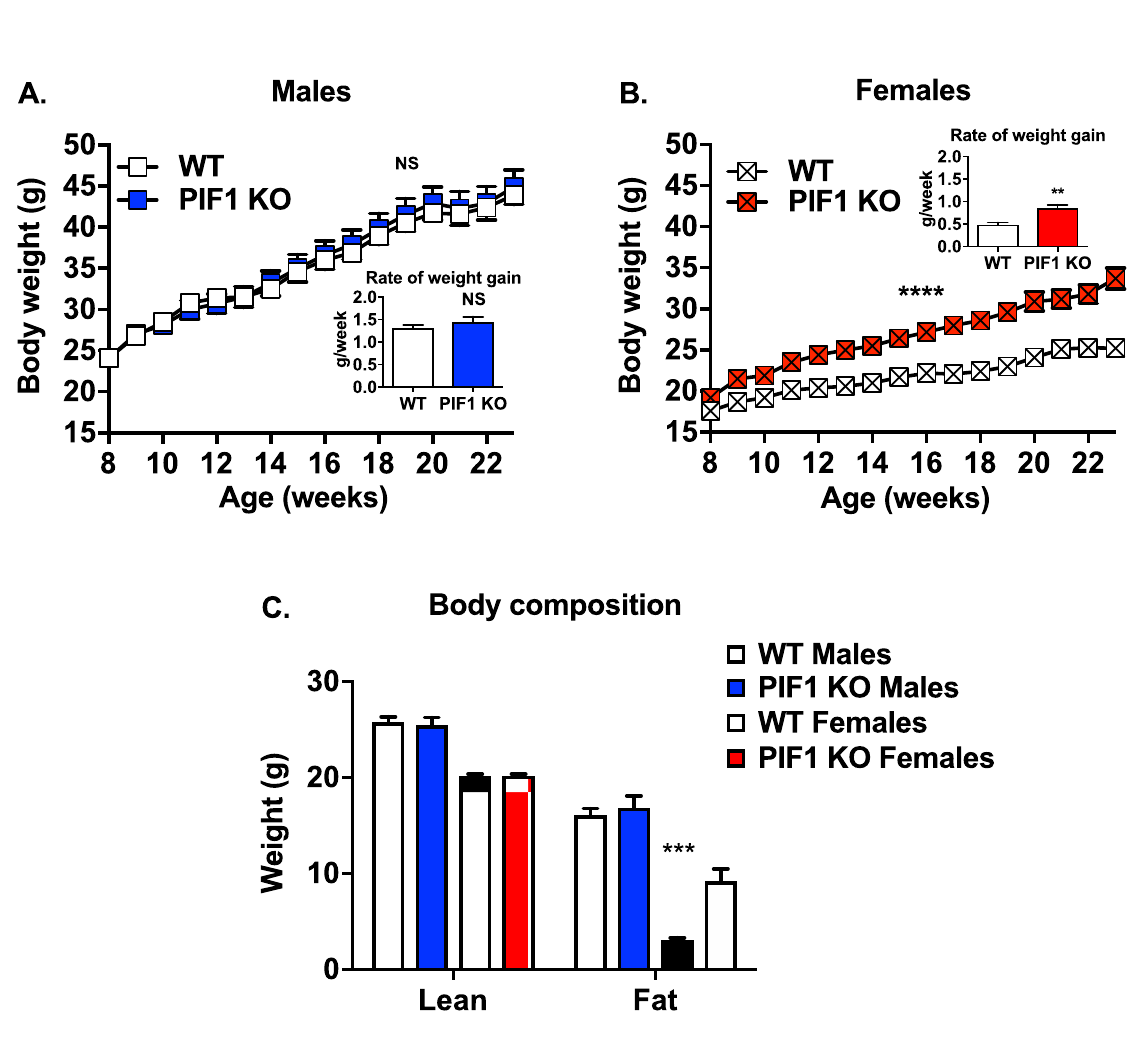
Fig 2. PIF1 knockout (KO) females, but not males, showed accelerated fat deposition compared with wild type (WT) mice during Western diet (WD) feeding. A) Average weekly body weight during 16 weeks of WD feeding in WT and PIF1 KO male (n = 12 and 11, respectively), or B) WT and PIF1 KO female mice (n = 8 and 12, respectively). Significance is reported for two-way ANOVA with repeated measures. Inset: Rate of body weight gain was calculated for each animal as a single value and used to determine p-values via Student’s t-test. C) Body composition as assessed through lean and fat mass measured in male WT (n = 11) and PIF1 KO (n = 11), male and female, 5-month-old mice after 12 weeks of WD feeding. Shown are mean ± SEM; p-values are calculated by Two-way ANOVA with Tukey’s posthoc test for multiple comparisons, shown are values for same gender WT vs PIF1 KO: �� p < 0.01; ��� p < 0.001; g = grams.